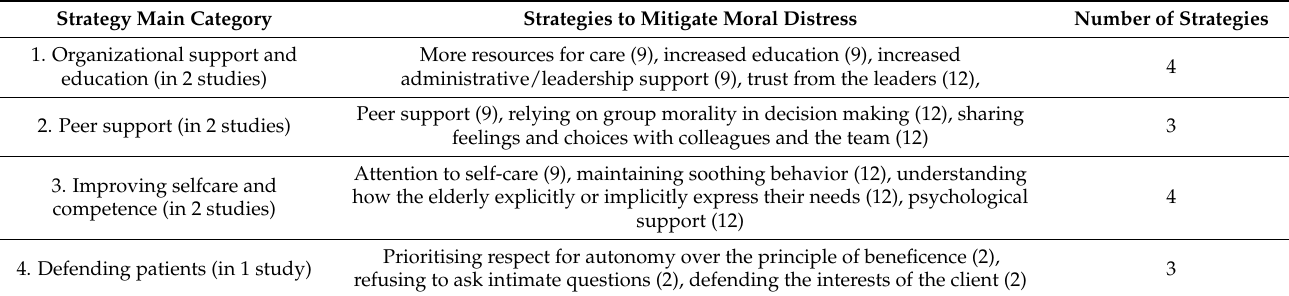
Table 4. Strategies to mitigate moral distress and their categorizations identified in the included studies. Each study is indicated using study numbers in Table